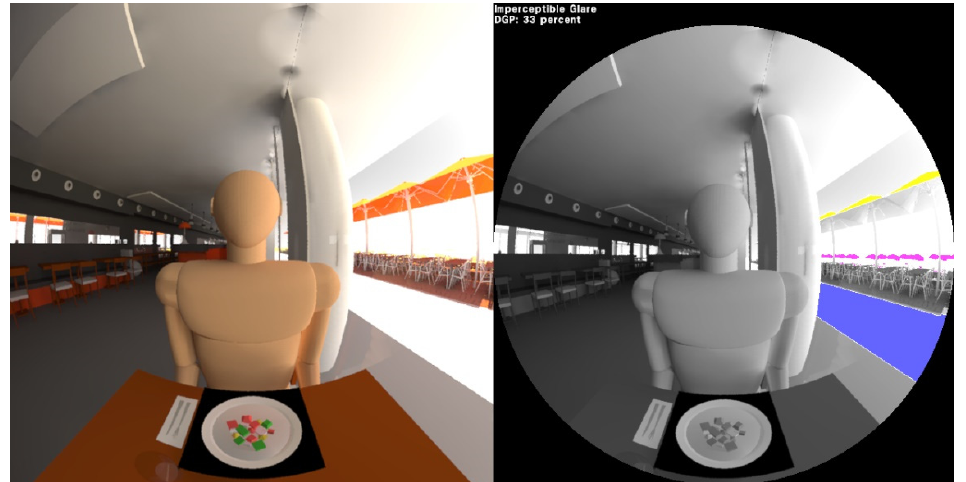
Figure 6. Changing the tablecloth background surface color results of visualization, DGP results and glare source image. The change was from clear orange (R, 1; G, 0.1; B, 0.01) tablecloth to dark black (R, 0; G, 0; B, 0) tablecloth. Table 3. The variation of DGP results changing the color of glare source surface or background surface.